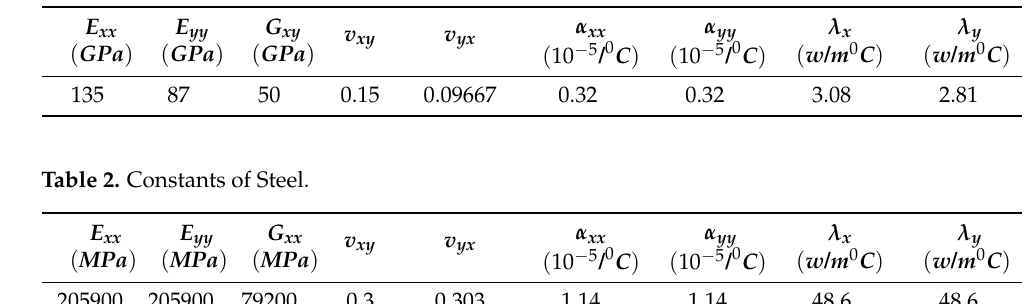
Table 1. Material constants of Tyrannohex.